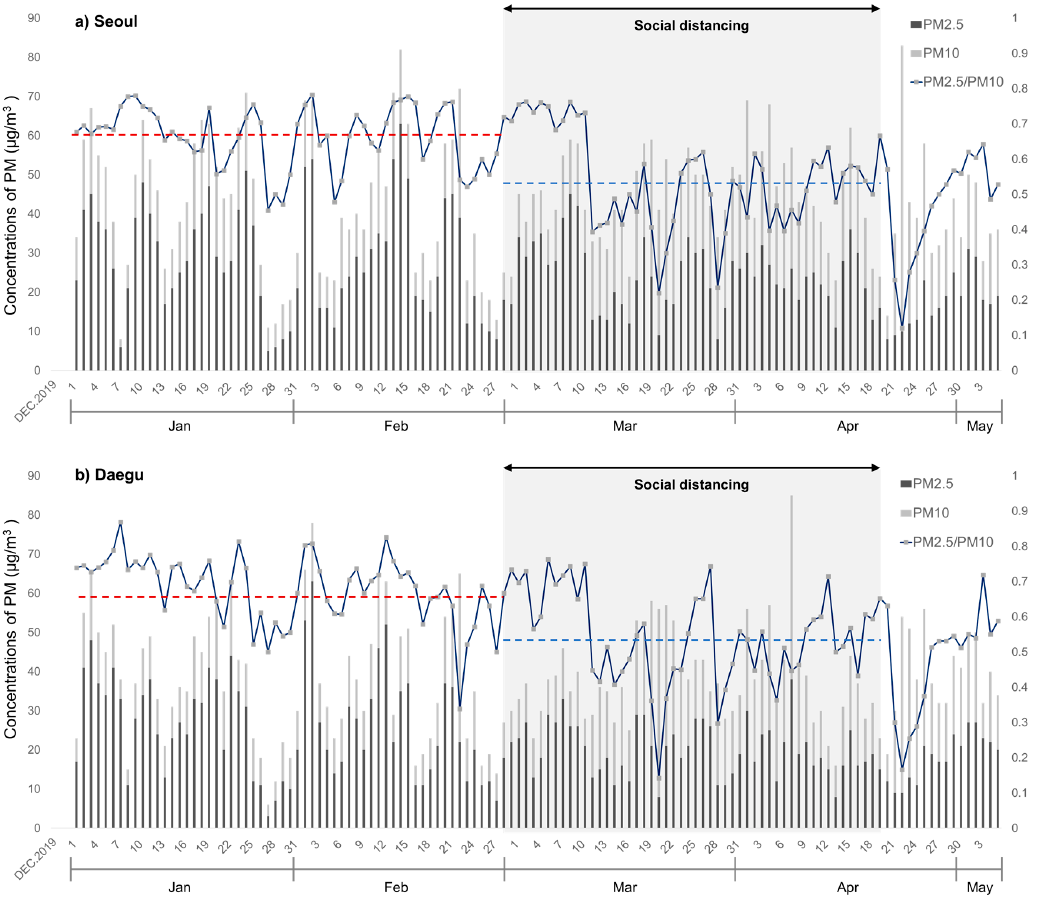
Figure 4. Changes of PM 2.5 / PM 10 ratio after social distancing ( a : Seoul, b : Daegu). Highlighted shadow represents the period of social distancing.